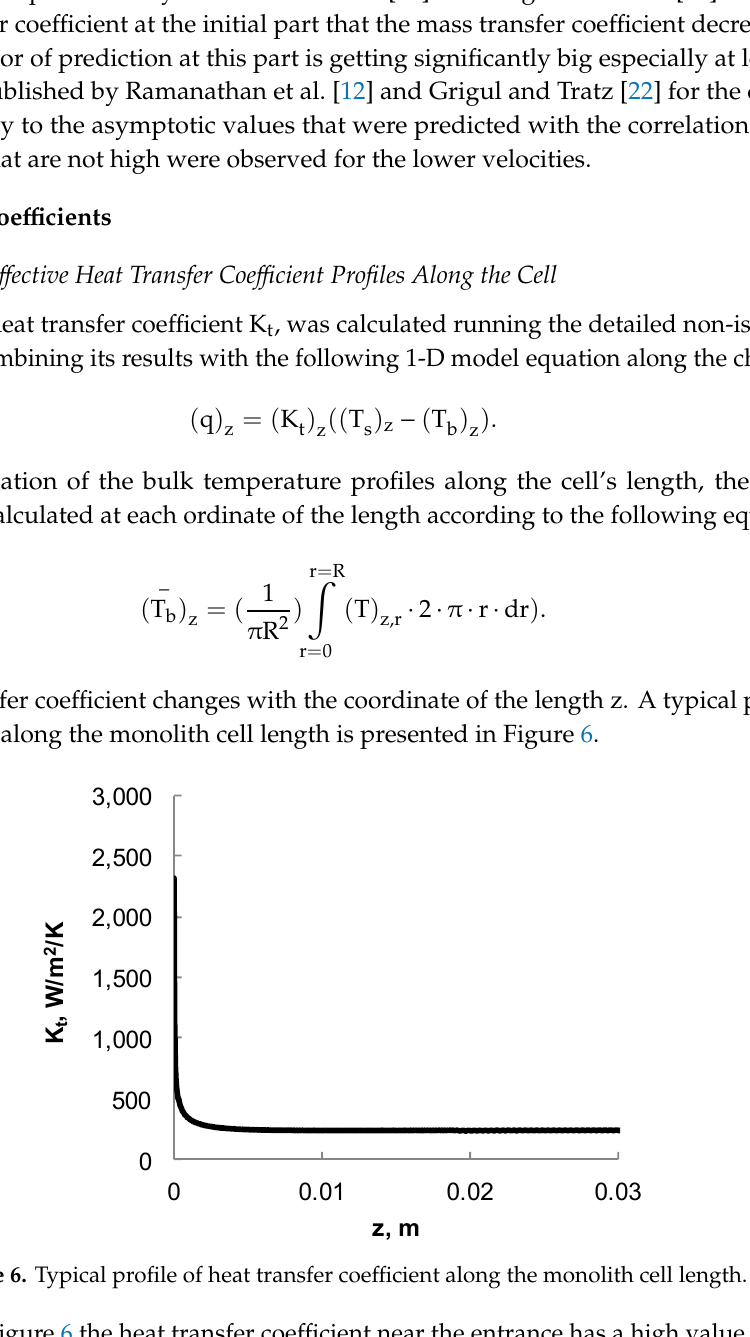
Figure 6. Typical profile of heat transfer coefficient along the monolith cell length.